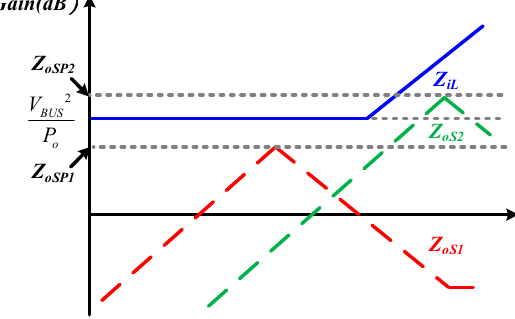
Figure 12. Two ways to design an LLC converter to stabilize a series system.